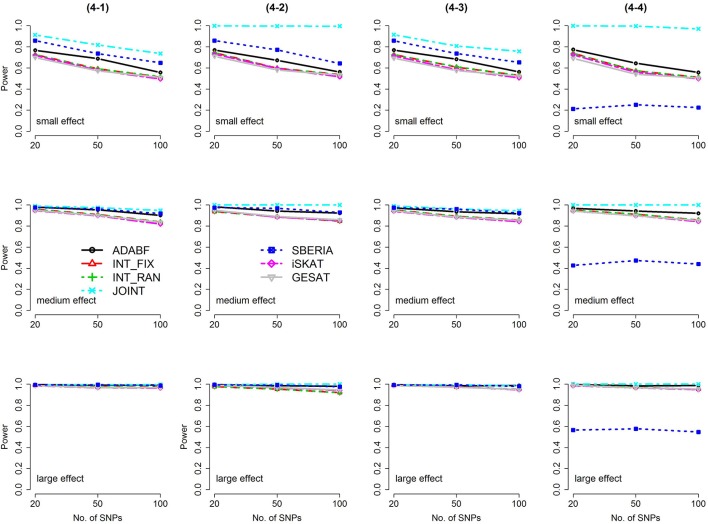
Power of the seven tests for continuous traits (4 SNP × E, from Scenario 4-1 to 4-4). The x-axis represents the number of SNPs in the gene, whereas the y-axis depicts the power at the nominal significance level α = 2.5 × 10−6. From the top row to the bottom row, the magnitudes of SNP main effects and SNP × E interaction effects were evaluated at three levels: small, medium, and large, respectively.